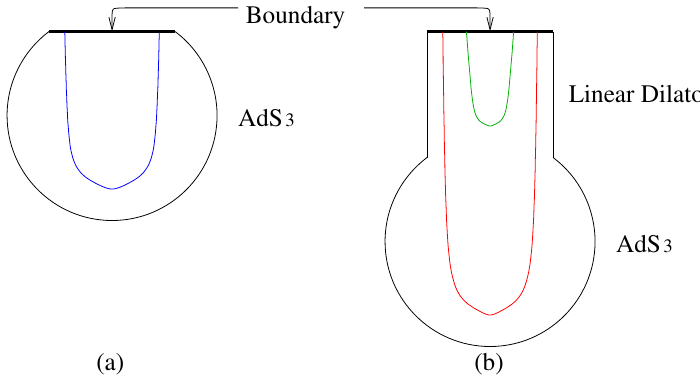
Figure 4 . Schematic illustration of Ryu-Takayanagi surface in background (2.10). In (a), we illustrate the case where µ , ε + , and ε − are all set to zero. In (b), we illustrate the configuration for large L in red, and the configuration with small L in green. Because of the cutoff dependence of S ( L ) , large L behavior of (a) and (b) are not identical. This difference goes away for cutoff independent quantity such as c ( L ) . The non-trivial embedding in the T coordinate that we illustrated in figure 2 is projected out in illustration